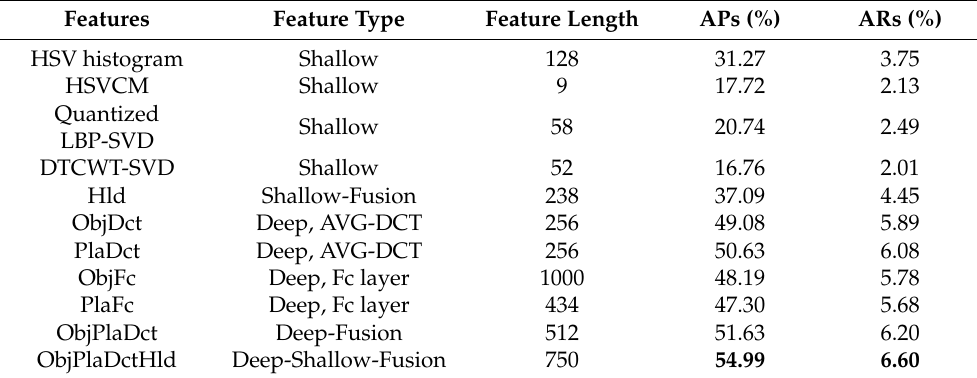
Table 2. APs and ARs results of using different features on Corel-5k dataset (Top NR = 12).